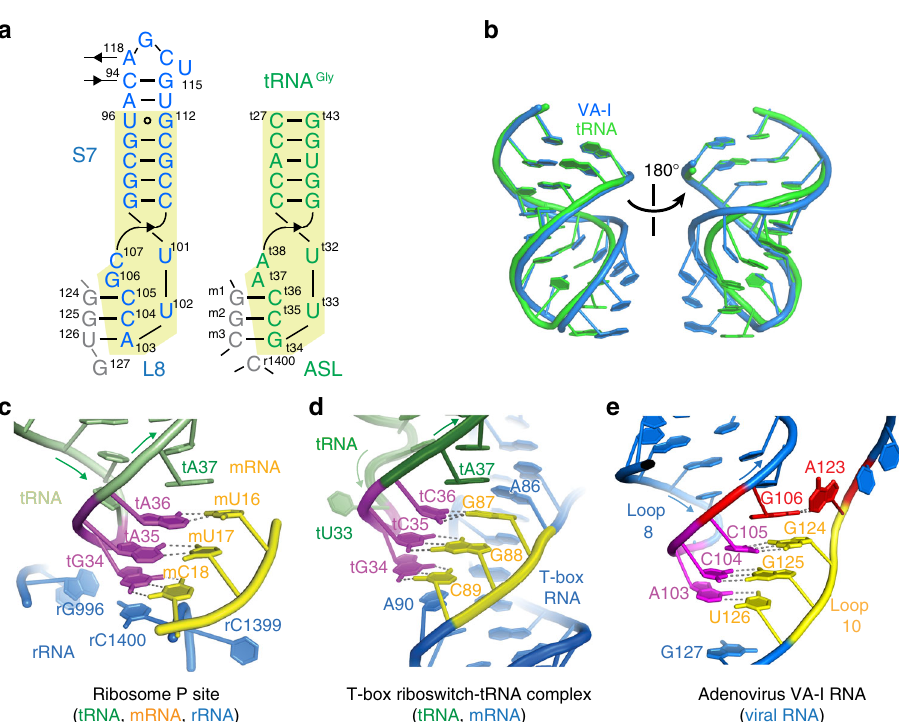
Fig. 6 Structural similarities with the tRNA ASL and codon – anticodon interactions. a Secondary structures of VA-I S7-L8 region and a tRNA Gly ASL. Their base-pairing partners, VA-I L10, mRNA codon, and rRNA are in gray. Numbering of tRNA, mRNA, and rRNA are preceded by “ t ” , “ m ” , and “ r ” , respectively. b Overlay of the tertiary structures. Overall RMSD is 2.2 Å. c Structural con fi guration of the codon – anticodon interactions in the P-site of the ribosome (PDB: 4V5D[https://www.rcsb.org/structure/4v5d]) 45,46 . The tRNA, mRNA, rRNA are shown in green, yellow, and blue, respectively. d A nearly identical structural con fi guration was observed in T-box riboswitch-tRNA co-crystal structures (PDB: 4LCK[https://www.rcsb.org/structure/4lck]) 47,48 . Note the cross-strand stacking by conserved purines (tRNA t37 and T-box A90). e Codon – anticodon-like interactions in the VA-I RNA central domain. The 3-bp duplex is presumably stabilized by stacking by G106, which occupies a position equivalent to tRNA purine